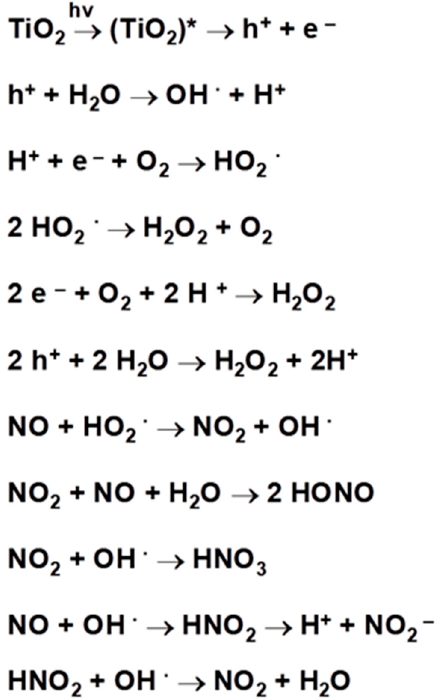
Scheme 1. Basic Processes at the Air/Catalyst Interface by the NO degradation.